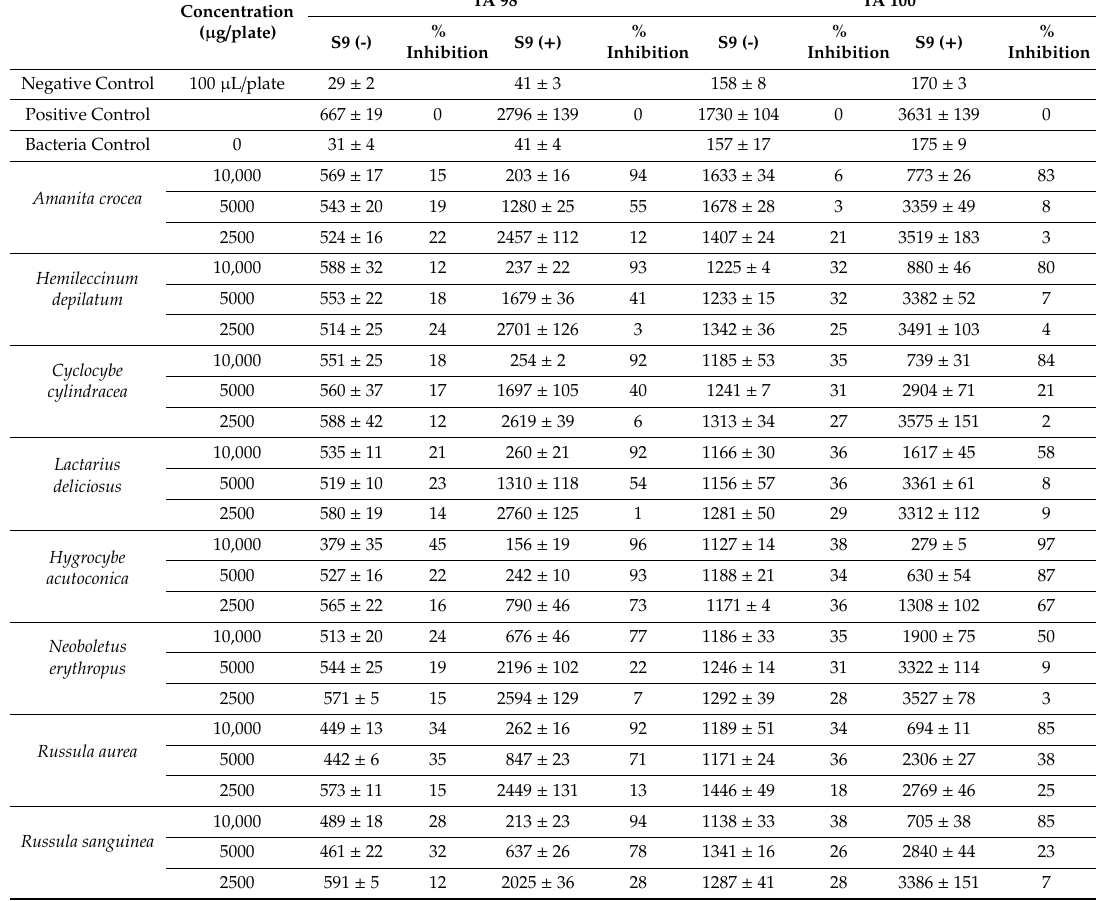
Table 6. Antimutagenic properties of the tested